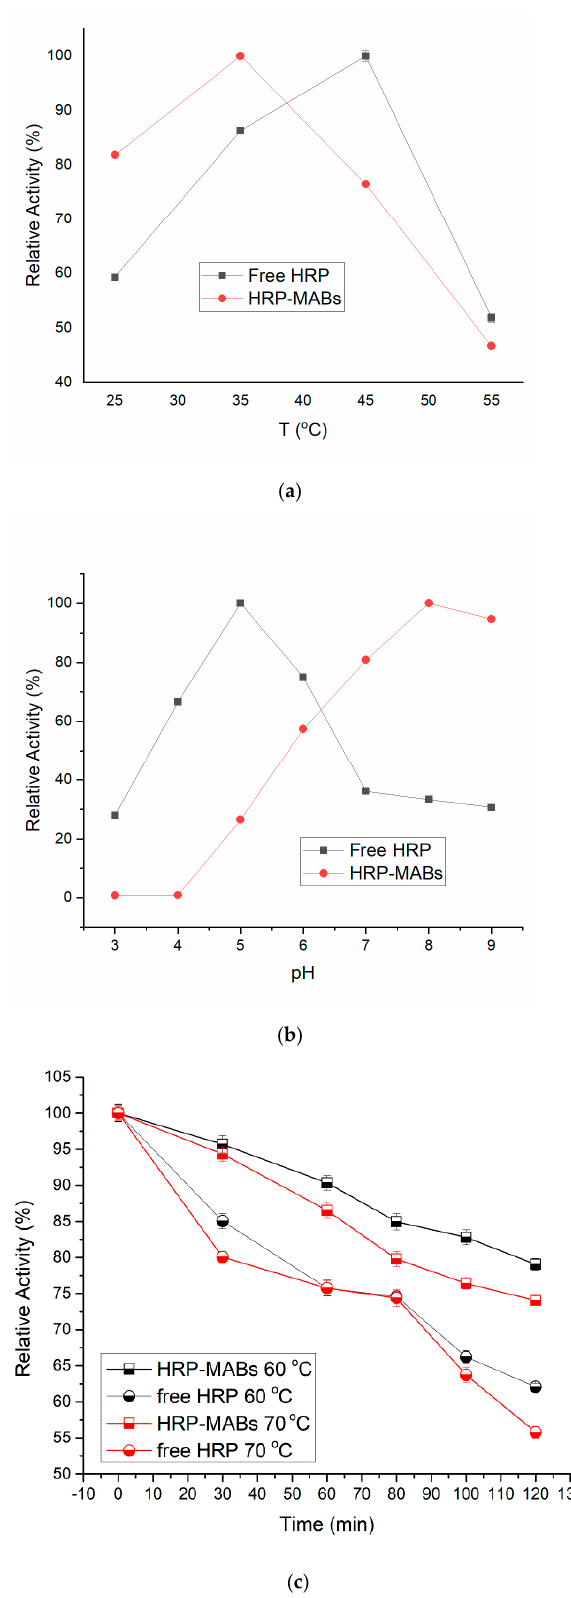
Figure 8. Effect of ( a ) temperature and ( b ) pH on activity of free and HRP-MABs and ( c ) thermal stability of free HRP and HRP-MABs according to the standard enzyme activity assay.